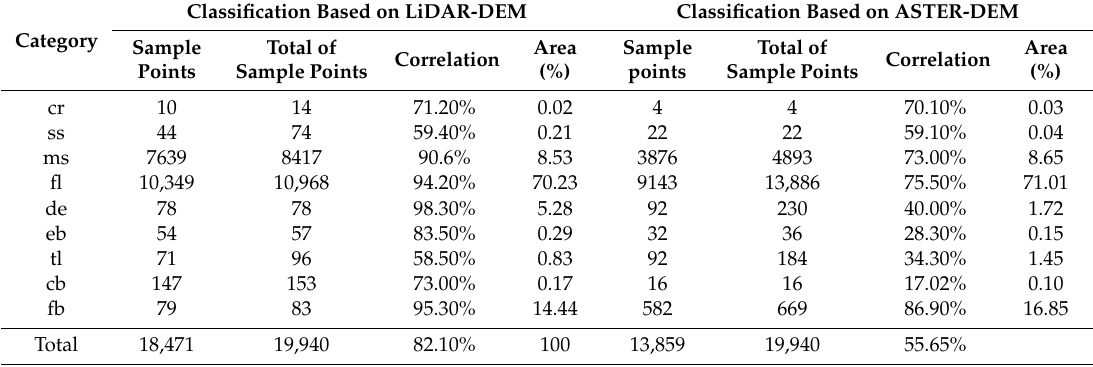
Table 8. Correlation of LiDAR-DEM based and ASTER-DEM based classifications and share of each category from the total area. Where cr is crest, ms is moderate hillside slope, ss is steep hillside slope, fl is flat land (unspecified), de is depression (open, closed), eb is embankment, tl is terraced land, cb is channel bank and fb is floodplain.